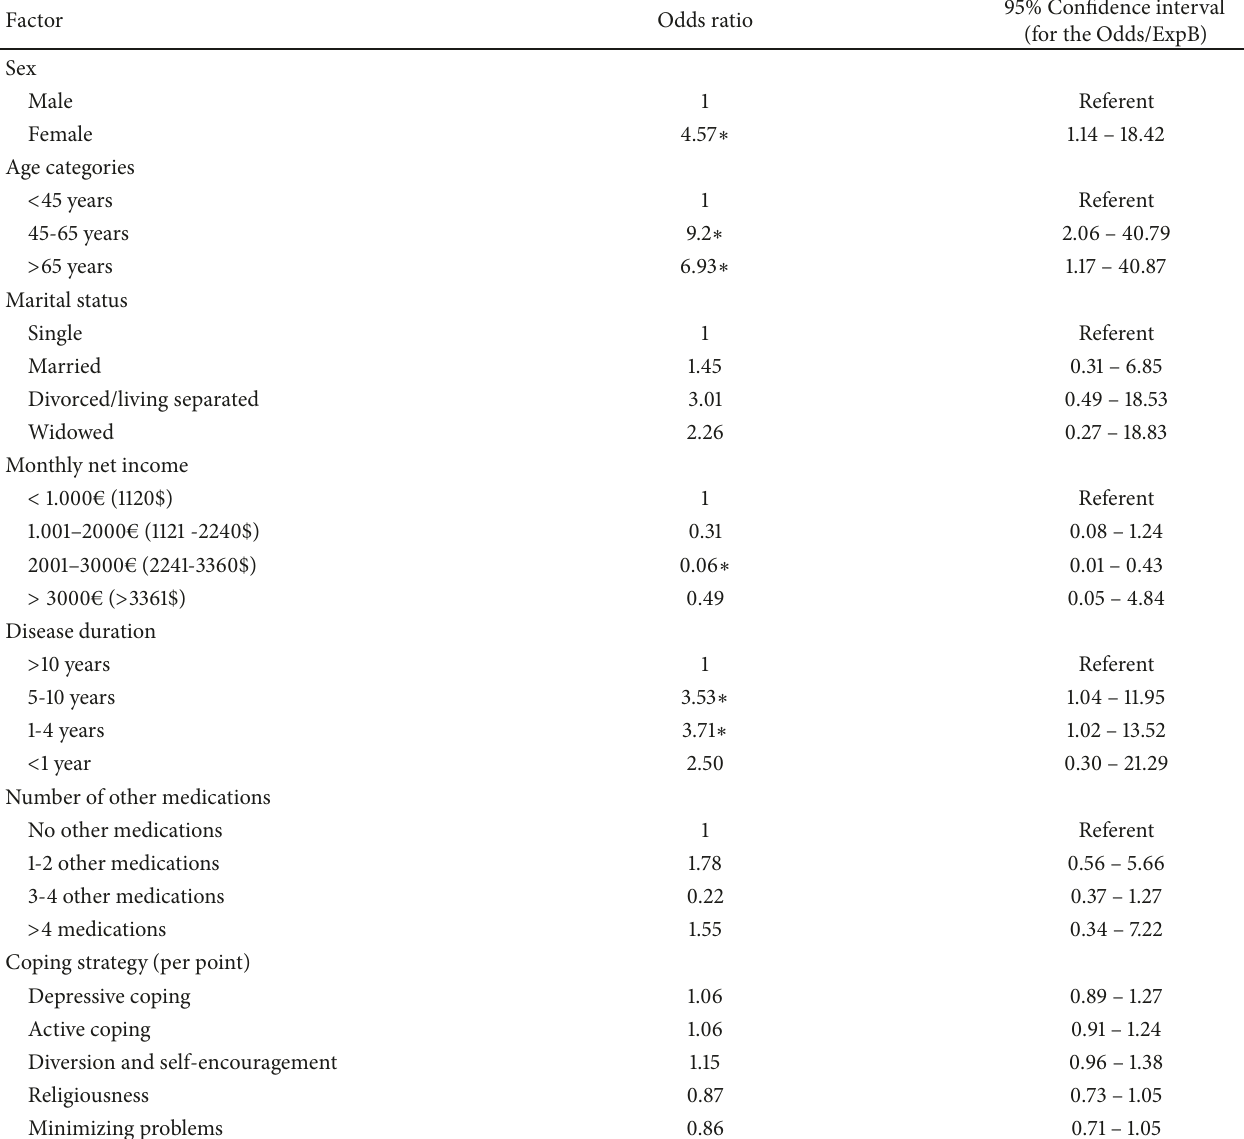
Table 4: Factors associated with medication